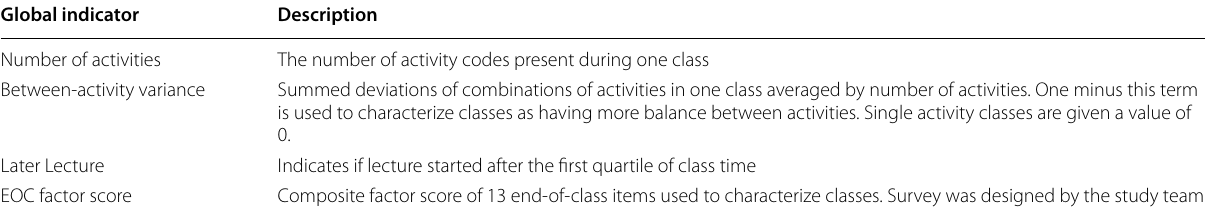
Table 2 Global indicators used as profile descriptors